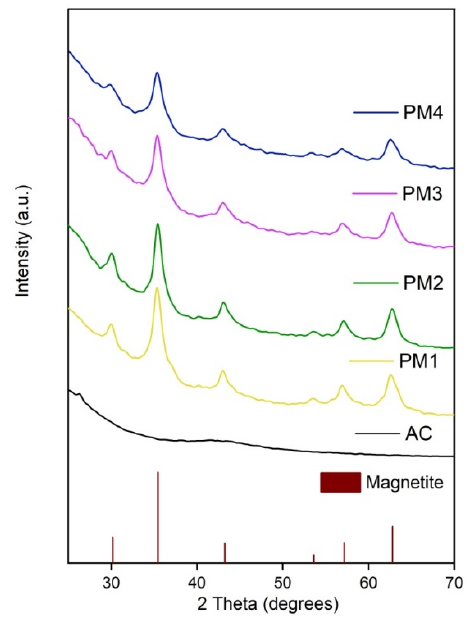
Figure 1. X-ray diffraction pattern of activated carbon and magnetic nanocomposites.